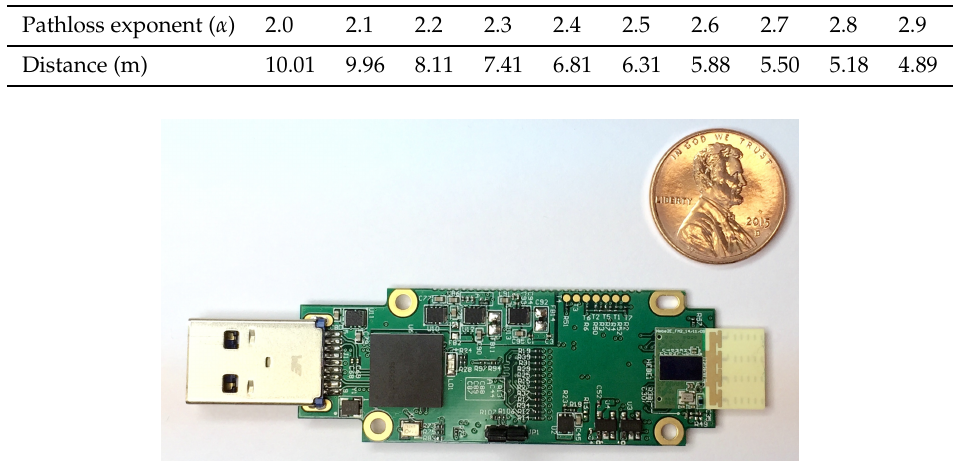
Table 3. Reachable distances according to pathloss exponents at MCS1.